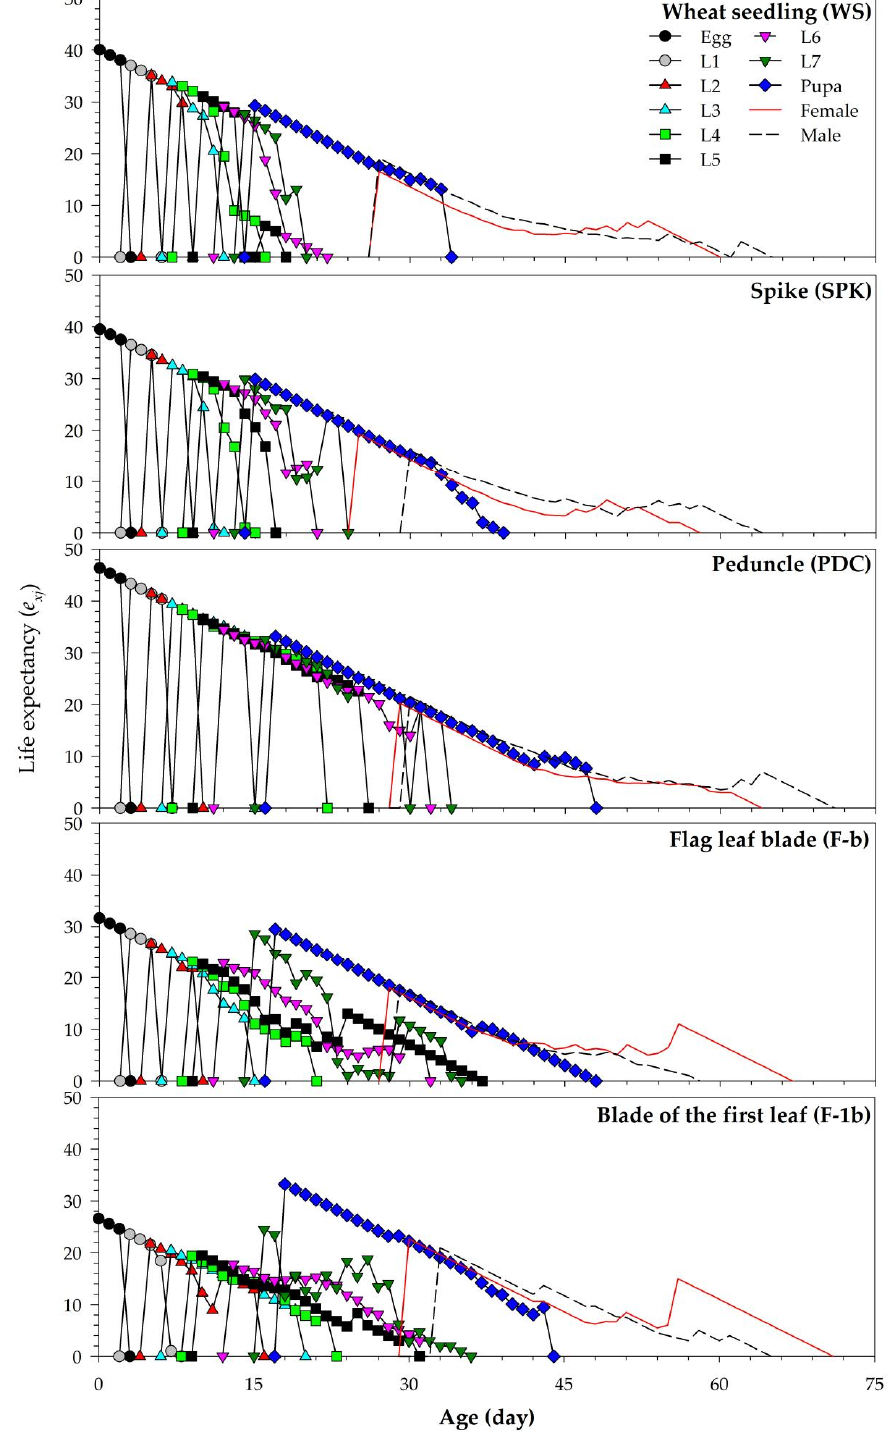
Figure 3. Age-stage-specific life expectancy ( e xj ) of the FAW fed on different wheat tissues in the